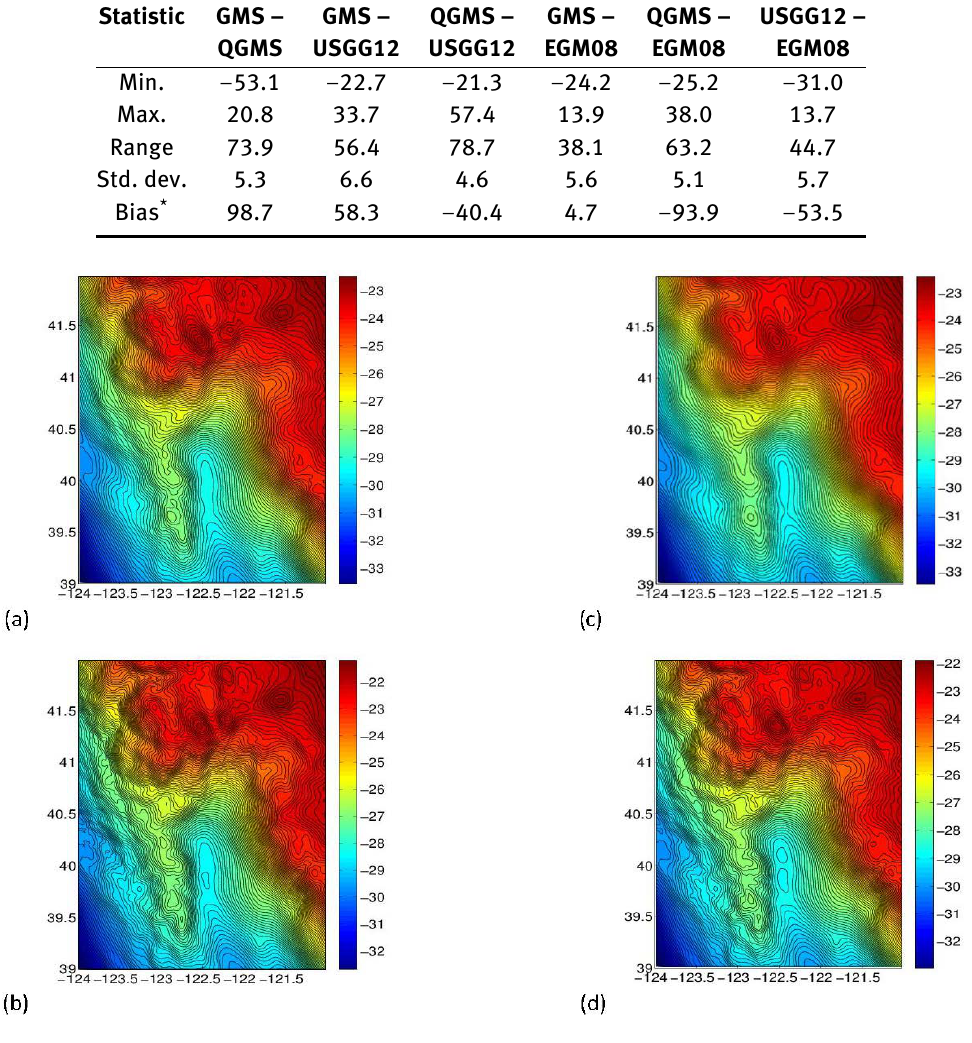
Figure 10: The GMS (a) and QGMS (b) geoid vs. EGM08 (c) and USGG12 (d) geoid for the California test area in 10 cm